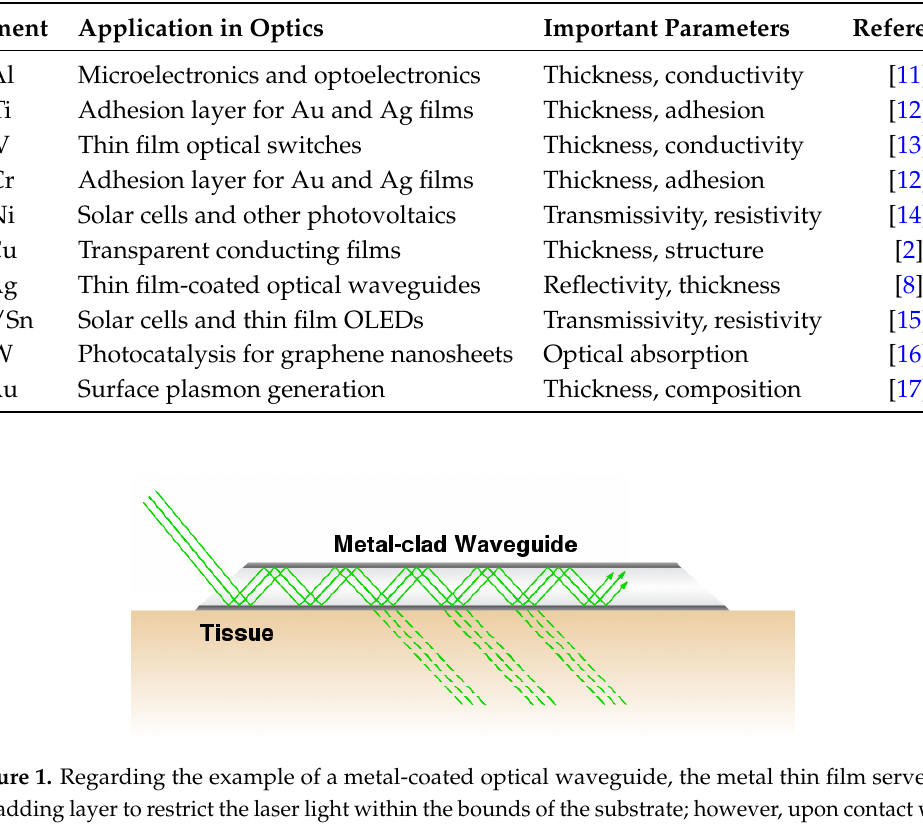
Table 1. Examples of photonics applications employing pure metal and metal-containing thin films, the majority of whose most important characteristics are either directly dependent on or can be indirectly related to the film’s thickness.